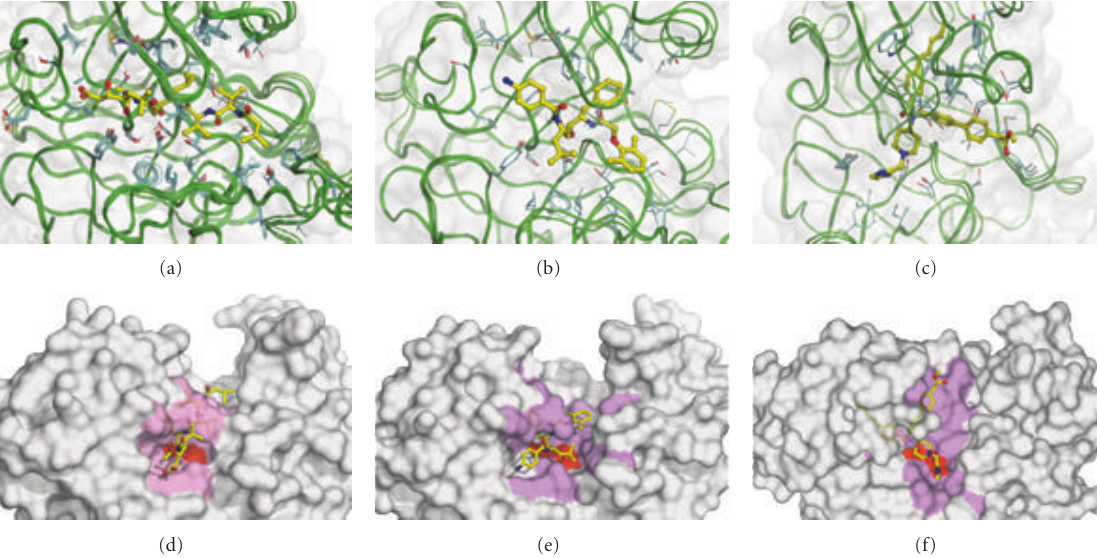
Figure 1: The di ff erent binding modes described for plasmepsin II ∗ . Closed (a), partially opened (b), and open (c). Protein backbones are represented as green ribbons. Ligands (pepstatin A (a), rs370 (b), and IH4 (c) in yellow), and all amino acids in their close vicinity (up to 6 Angstrom) are shown in stick using a color code by the atom type. Panels D to F show the solvent accessible surface of a representative protein from each binding mode (PDB ID: 1XDH (a), 1LF2 (b), and 2BJU (c)). The zone up to 4 angstrom away from the ligands is colored in magenta, and catalytic residues D34 and D214 are shown in red. These figures were prepared with PYMOL. ∗ According to Luksch and colleagues